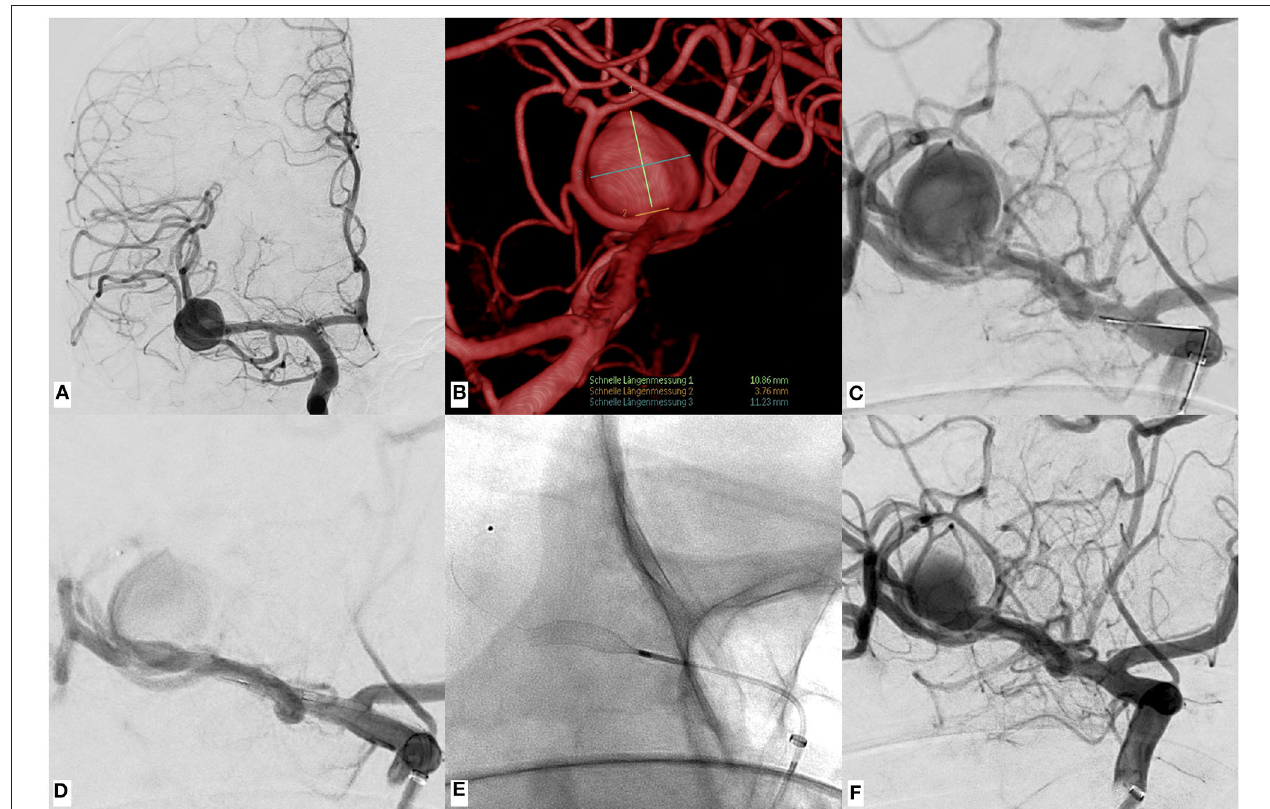
FIGURE 2 | An example of p48MW hydrophilic coating (HPC) implantation in the right M1–M2 junction for treatment of an un-ruptured saccular aneurysm arising from the right middle cerebral artery (MCA) bifurcation. (A) Digital subtraction angiography (DSA) run in standard AP projection showing the large, laterally developed saccular MCA aneurysm. (B) Volume rendered reconstruction of the rotational 3D angiography revealing the relationship of the aneurysm to the associated MCA branches as well as the lesion dimensions. (C) Pre-intervention DSA run in working projection. (D) Control injection in working projection after definition of the distal landing zone. (E) Corresponding non-subtracted device radiogram. Note the position of the MW in the M2 segment, additionally stabilizing the device-microcatheter unit during deployment. (F) Final DSA run after p48MW HPC implantation demonstrates significantly reduced arterial filling compared with the initial diagnostic DSA (O’Kelly Marotta